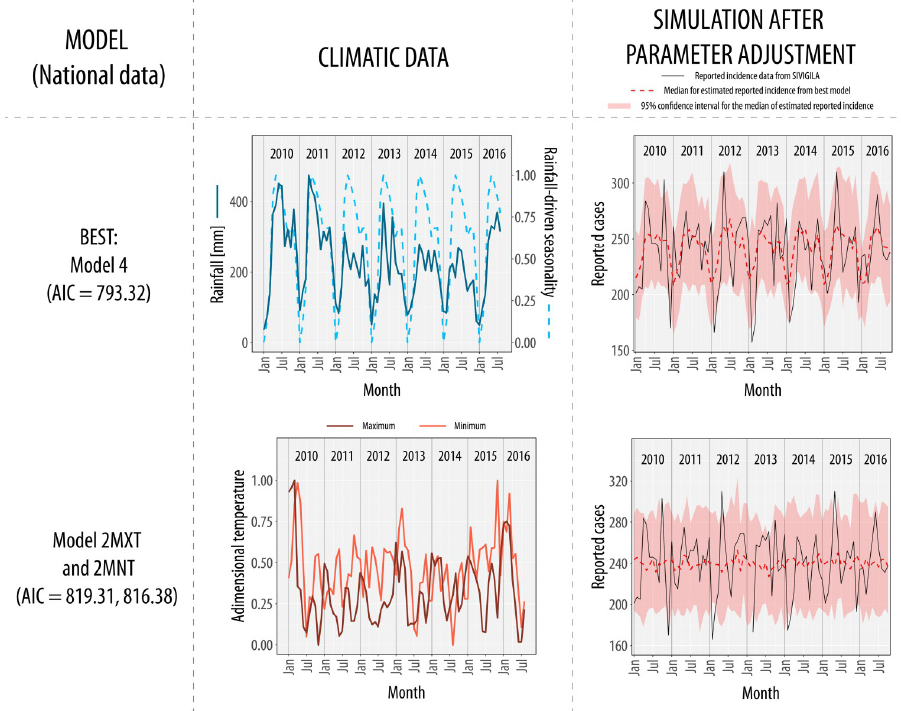
Fig 2. Climatic data and results of the modeling scheme applied to national data. We show the results of the best model (Model 4) and the models with temperature covariates (Model 2MXT and Model 2MNT) for national data. Climatic data shows the climatic covariates used per each model, and the simulation after parameter adjustment represents the model with the best combination of parameters that capture incidence dynamics. Note that the best model (Model 4) had lower AIC than the other models and note the difference between rainfall-driven seasonality (Dashed light-blue line) and rainfall signal (Dark blue line). In the simulations, Model 4 captures better incidence seasonality than Model 2MXT and Model 2MNT, where the median of the simulations (Dashed red line) is relatively constant.